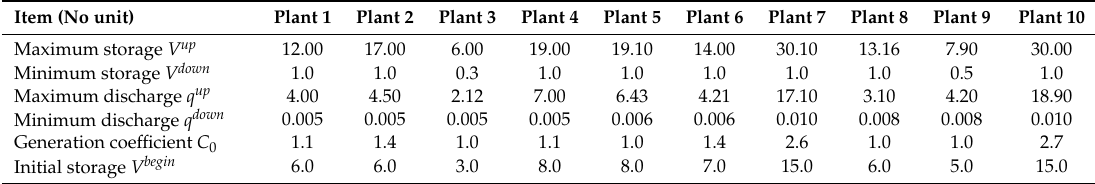
Figure 7. Topological structure of the mature multi-reservoir system. Table 5. The computational parameters of the mature multi-reservoir system. Table 6. Local inflow of the mature multi-reservoir system.